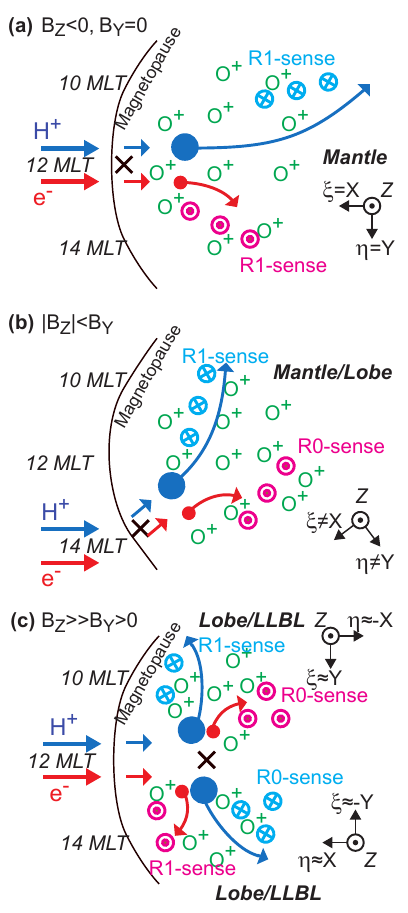
Figure 6. Expected distribution of the positive/negative charges (FAC into/out from the ionosphere) in the Northern Hemisphere in the exterior cusp–plasma mantle region for three different IMF orientations: (a) purely southward IMF, (b) duskward IMF, and (c) strongly northward IMF. Here, both the mass-loading effect and the IMF effect on the solar wind flow in the exterior cusp are consid- ered. Morphologically, the downstream (plasma mantle for south- ward IMF and LLBL northward IMF) corresponds to the lobe re- gion; see text for further explanations. Longitudinal charge separa- tion (Yamauchi et al., 1993a) is not included here. Blue colour rep- resents flow and charge separation of positive charges (H + ) of the solar wind, and resultant FACs (flowing into the ionosphere). Red colour represents flow and charge separation of negative charges (e − ) of the solar wind, and resultant FACs (flowing out from the ionosphere). Coordinate systems are shown in two ways: X - Y - Z based on the solar wind direction outside the magnetosphere (sim- ilar to GSM coordinate), and ξ - η - Z based on the local solar wind direction inside the exterior cusp (in the same manner as Fig. 3). The abbreviations “R1-sense” and “R0-sense” indicate polarities of the charge accumulation consistent with the flowing directions of cusp Region 1 FAC and cusp Region 0 FAC, respectively. Note that the different gyroradii between the solar wind protons and electrons are overemphasized in the figure (a 100kms − 1 proton in a 30nT magnetic field has a gyroradius of only